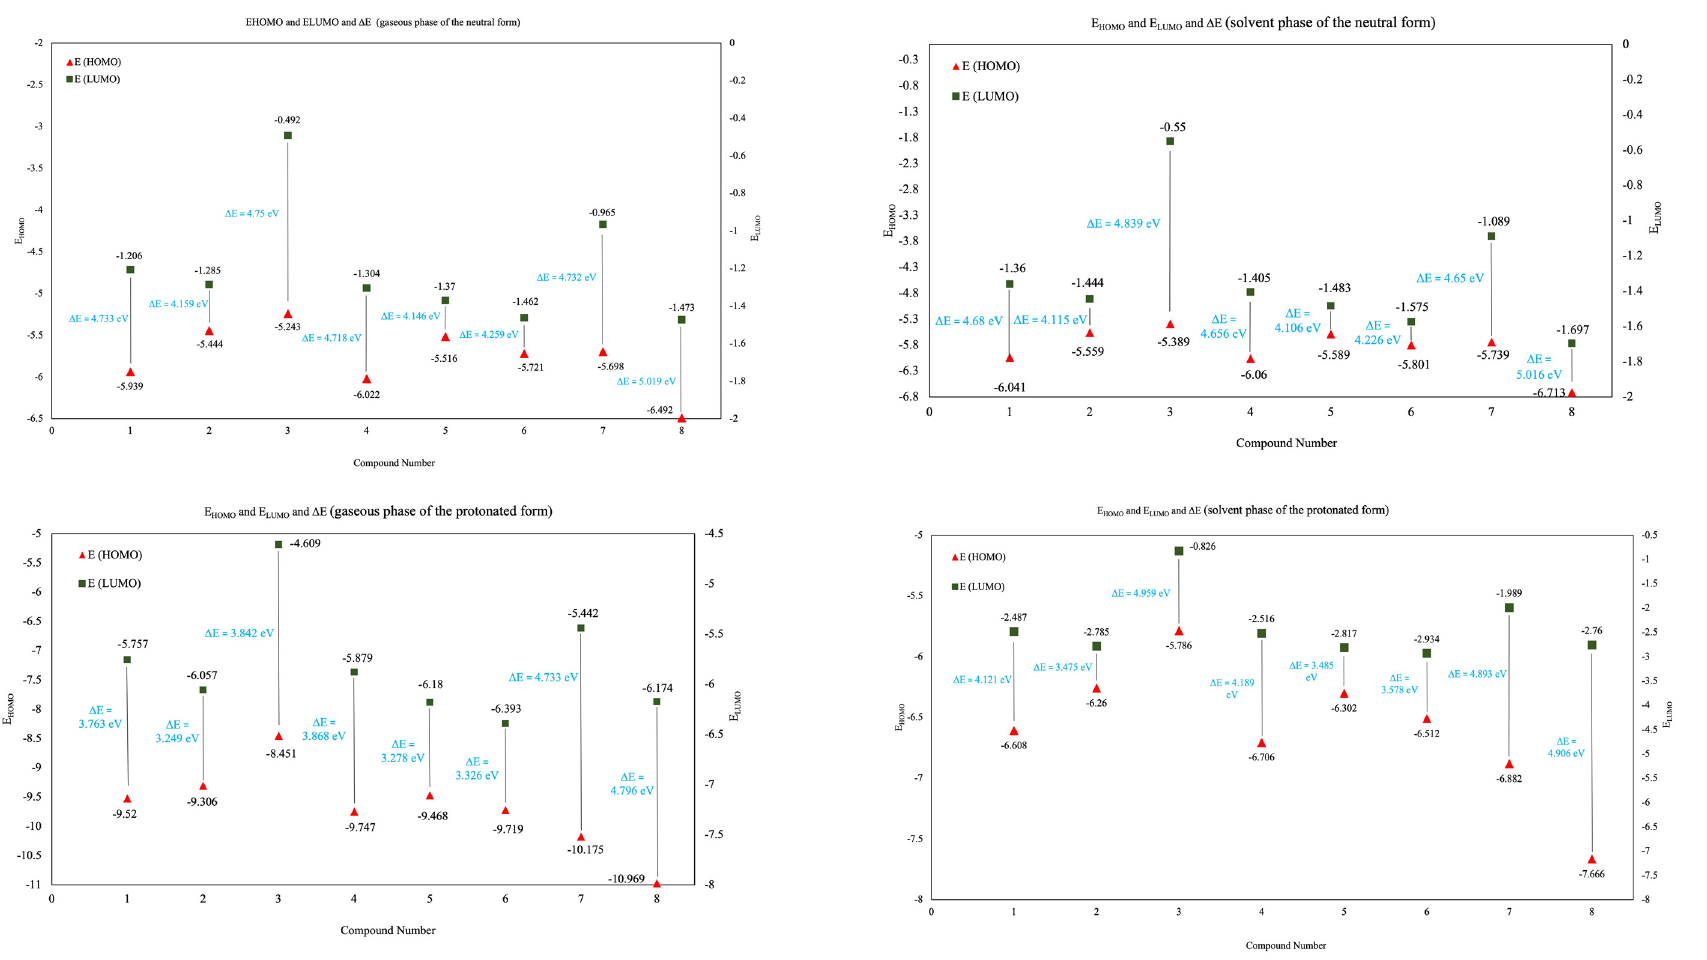
Figure 16. Comparative representation of E HOMO and E LUMO for the neutral and protonated forms of studied compounds 1 – 8 calculated in the gaseous and solvent phases using water and by applying PCM model at the B3LYP/6-311G++(d,p).